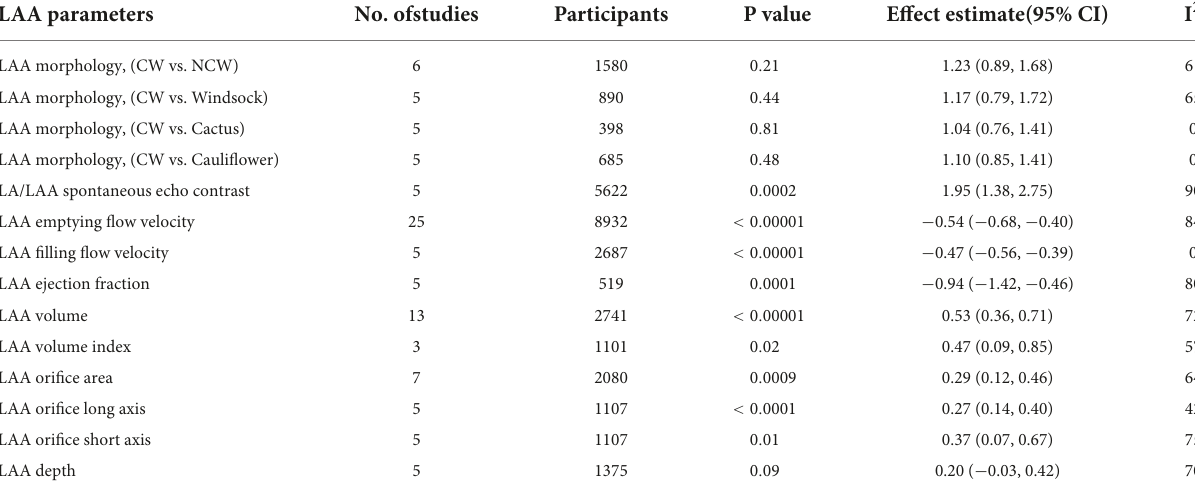
TABLE 1 Analysis of the association of left atrial appendage (LAA) parameters with the post-ablation atrial fibrillation (AF) recurrence. LAA parameters No. ofstudies Participants P value Effect estimate(95% CI) I 2 LAA morphology, (CW vs. NCW) 6 1580 0 . 21 LAA morphology, (CW vs.